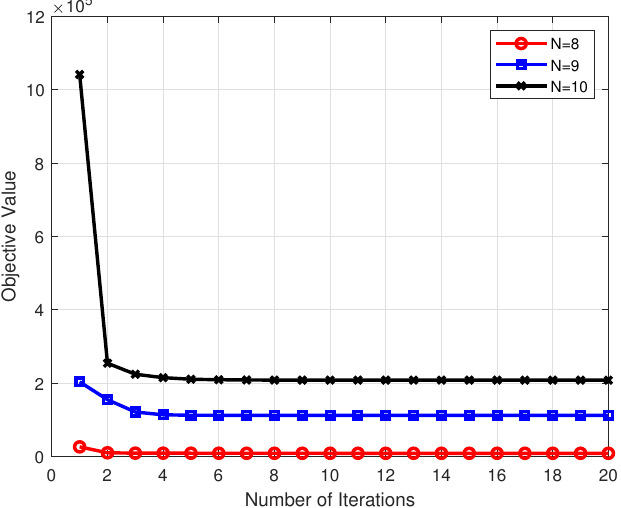
Figure 9. Convergence of the fixed-time allocation-based